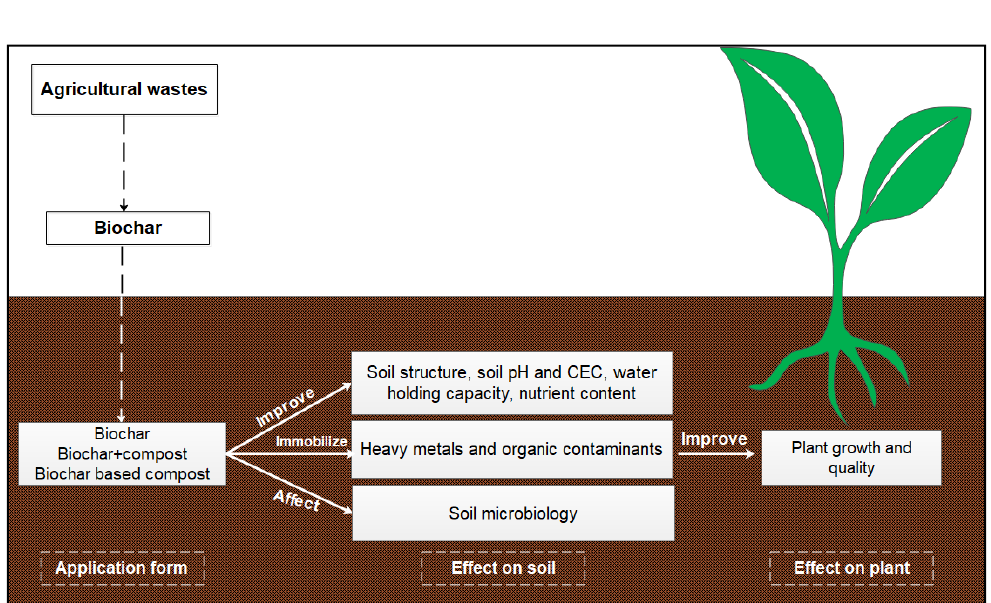
Figure 2. Benefits of biochar amendment for soil and plant production.